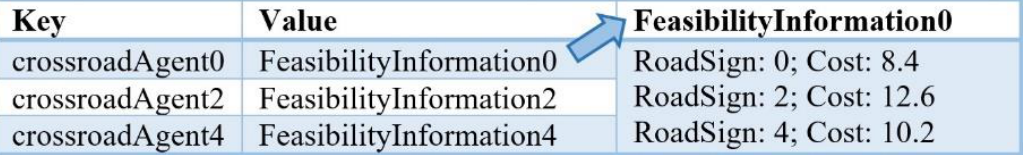
Figure 8. An illustration of the feasibility information (FI) held by the pheromone container (PhC) named “crossroadAgent8”.